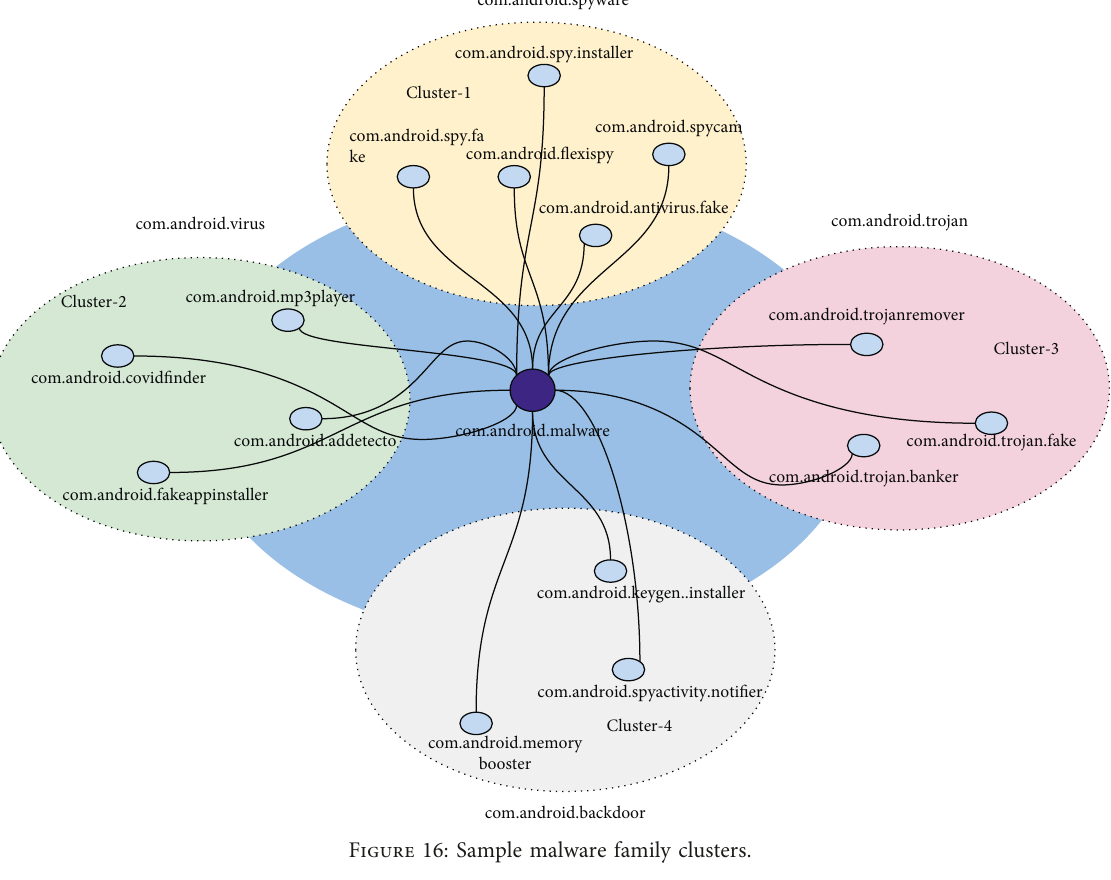
Figure 16: Sample malware family clusters.